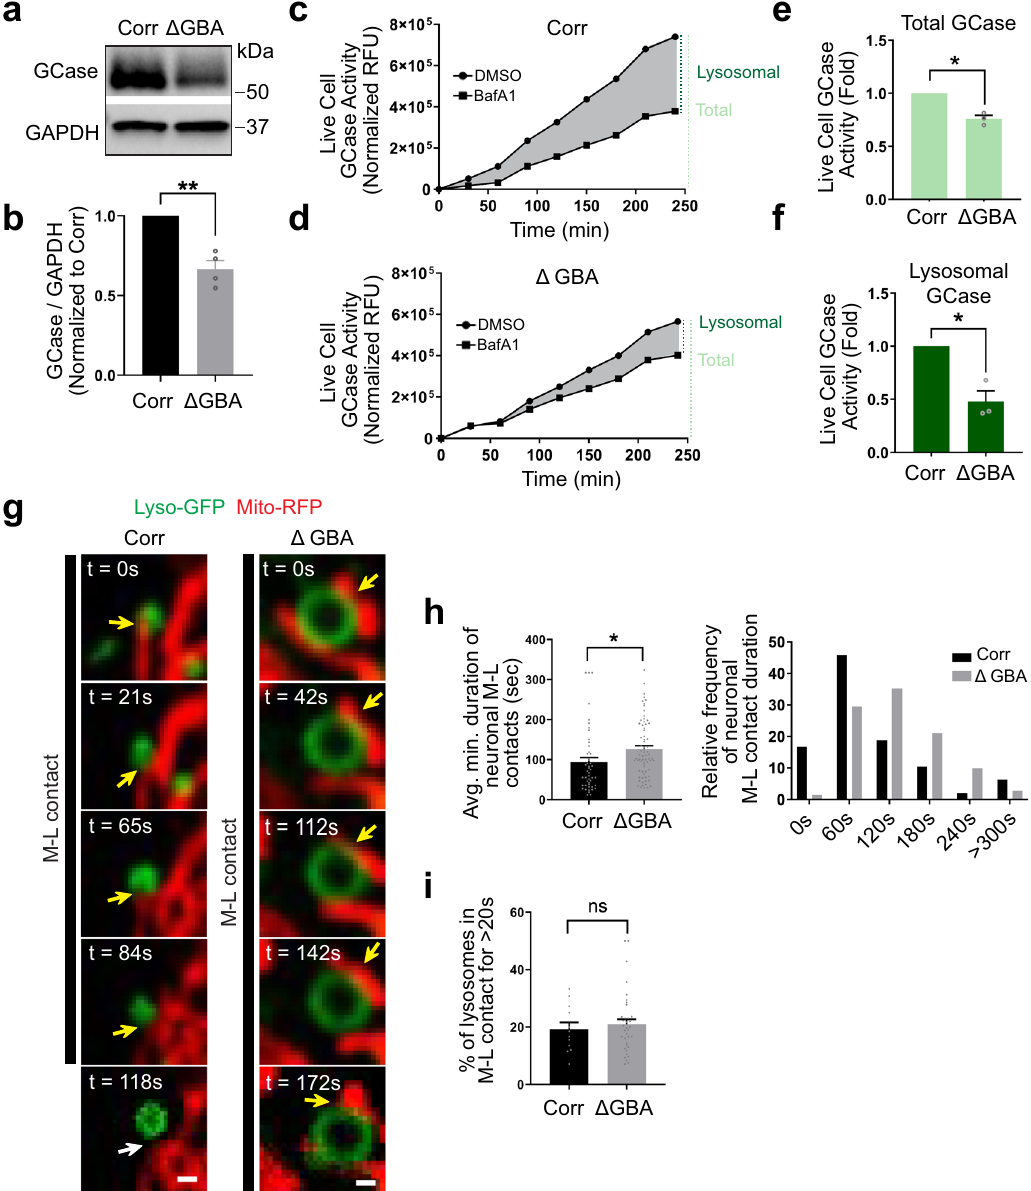
Fig. 3 Loss of GCase activity disrupts mitochondria – lysosome contact untethering in GBA1 -PD patient dopaminergic neurons. a , b Western blot analysis of PD patient-derived mutant GBA1 dopaminergic neurons ( Δ GBA; het 84GG) and its CRISPR-corrected isogenic control (Corr) neurons. GCase level was signi fi cantly reduced in Δ GBA neurons ( N = 4 independent experiments). Paired two-sided Student ’ s t -test; ** p = 0.0083. c – f Δ GBA and Corr neurons were treated with either DMSO or BafA1 and subjected to live-cell GCase activity analysis. e Quanti fi cation of the area under each curve (AUC) demonstrates decreased total GCase activity in Δ GBA neurons. Paired two-sided Student ’ s t -test; * p = 0.0183. f Lysosomal GCase activity was calculated by subtracting BafA1 values from DMSO. Values are expressed as fold-change compared to isogenic controls ( N = 3 independent experiments). Paired two-sided Student ’ s t -test; * p = 0.0352. g Representative time-lapse confocal images of contacts between mitochondria (red, Mito-RFP) and lysosomes (green, Lyso-GFP) in Corr (left) and Δ GBA (right) human neurons. Yellow arrows mark stable M – L contacts. White arrows mark the site of M – L contacts after contact untethering. Black line shows duration of contacts. Scale bar = 500 nm (see Supplementary Movies 7 and 8). h Quanti fi cation of average minimum duration (left) and relative frequency distribution of the duration of stable M – L contacts (right), showing increased duration of stable M – L contacts in Δ GBA neurons ( n = 48 contacts from Corr and n = 71 contacts from Δ GBA, N = 3 independent experiments). X -axis of the histogram represents bin centers. Bin width = 60 s. Unpaired two-sided Student ’ s t -test; * p = 0.0204. i Percentage of lysosomes contacting mitochondria (for >20 s) ( n = 12 Corr and n = 36 Δ GBA neurons, N = 3 independent experiments). Unpaired two-sided Student ’ s t -test. For all quanti fi cations, data are means ± S.E. M.; * p ≤ 0.05, ** p ≤ 0.01, ns: not signi fi cant.